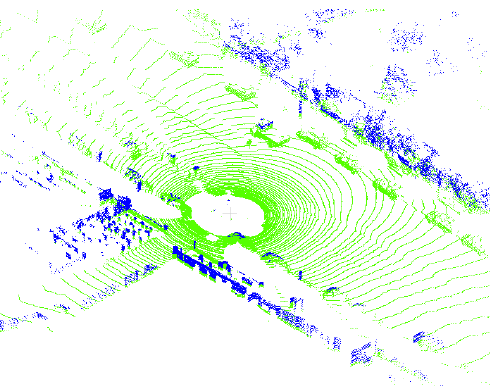
Figure 3. Schematic diagram of a point cloud grouping. According to the height, the point cloud is divided into two groups, the blue group and the green group. It is clear that the green group contains more